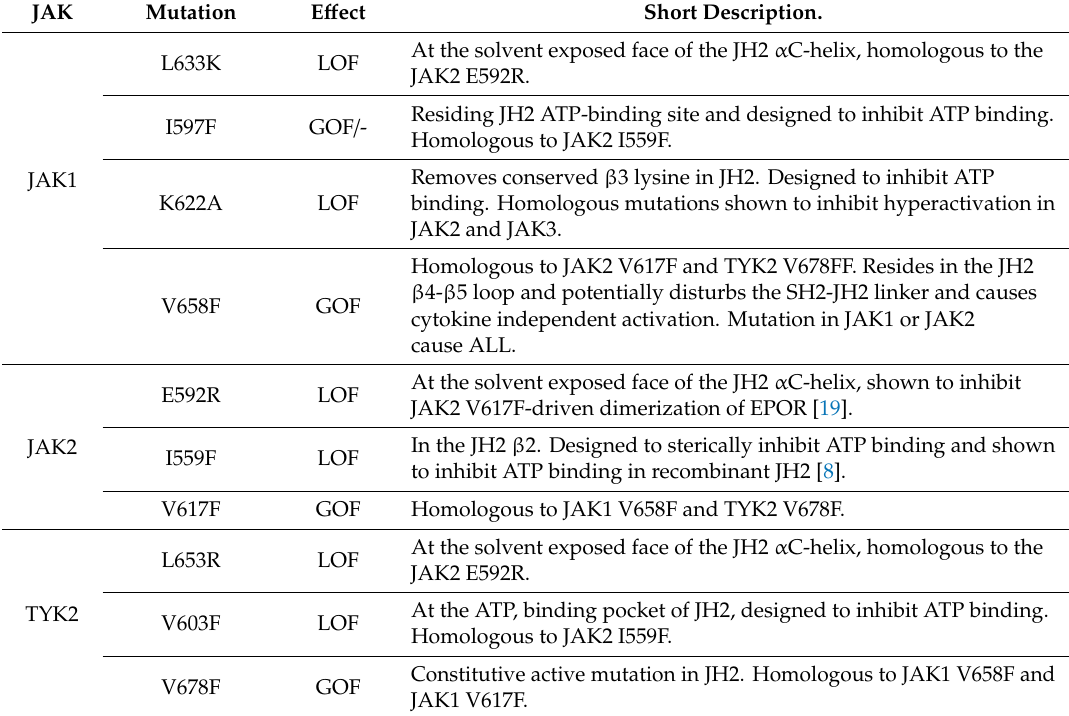
Table 1. Mutations used in this study qualified as loss-of-function mutations (LOFs) or gain-of-function mutations (GOFs) based on the shown e ff ects (-, designates as neutral). JAK Mutation E ff ect Short